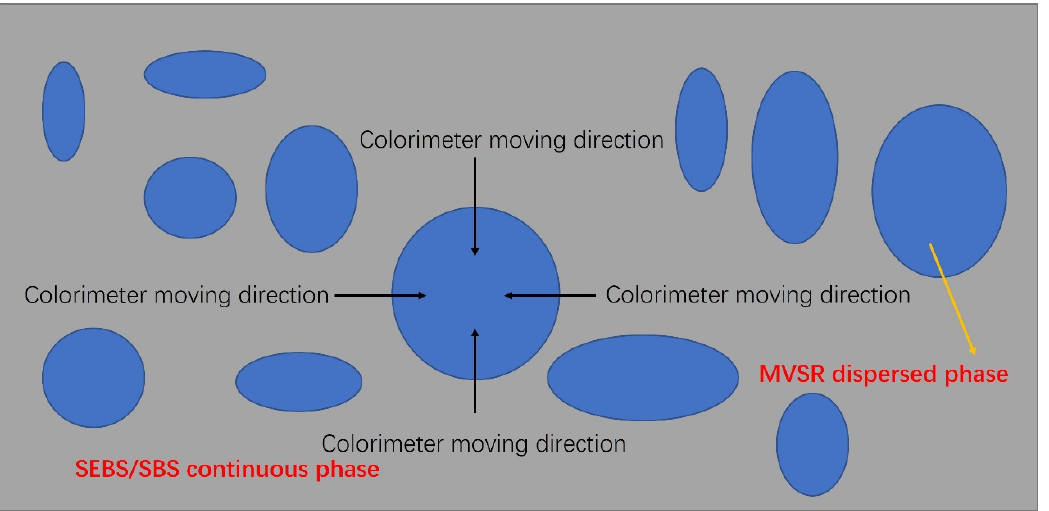
Figure 2. The test method for the colorimeter to test the size of the compatibility layer in TPSiV.